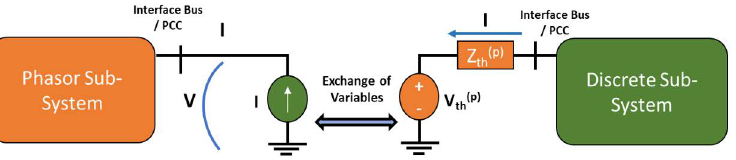
Figure 2. Equivalent circuits and boundary conditions for interaction between two simulation do- mains.